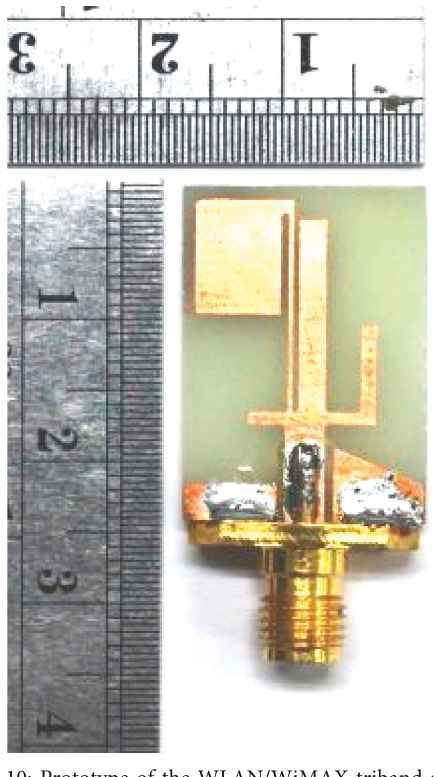
Figure 10: Prototype of the WLAN/WiMAX triband antenna.